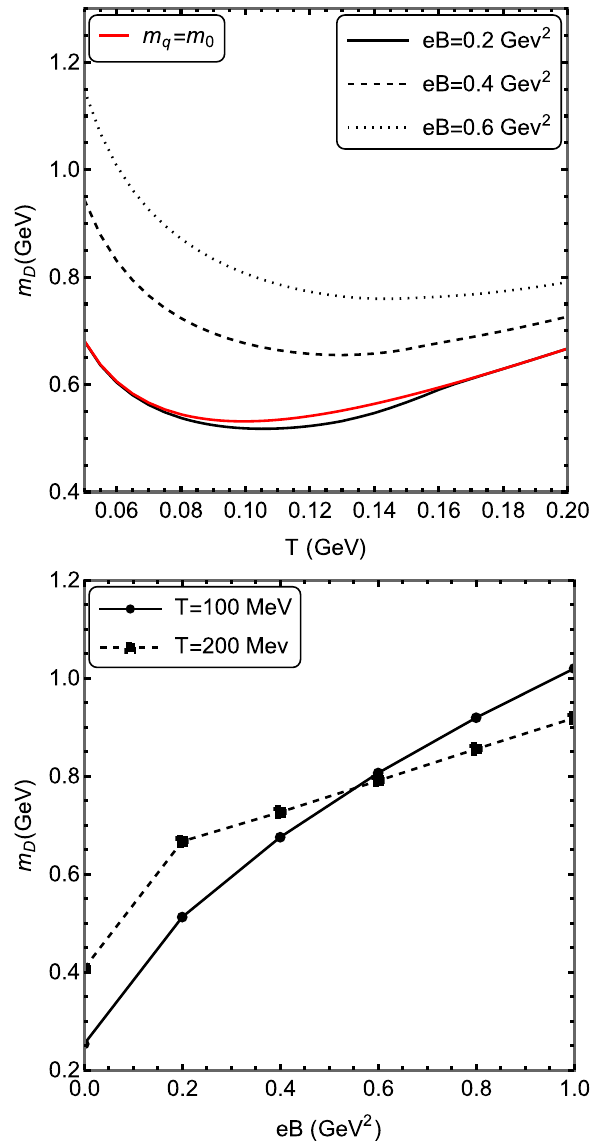
Fig. 2 VariationoftheDebyemass( m D )withtemperaturefordifferent values of magnetic fields eB = 0 . 2 (black solid line), 0 . 4 (dash line), 0 . 6 (dotted line) GeV 2 in left panel and with magnetic field for different values of temperatures T = 100 (black solid line), 200 (dash line) MeV in right panel. Red solid line in left panel denotes for massless quark case